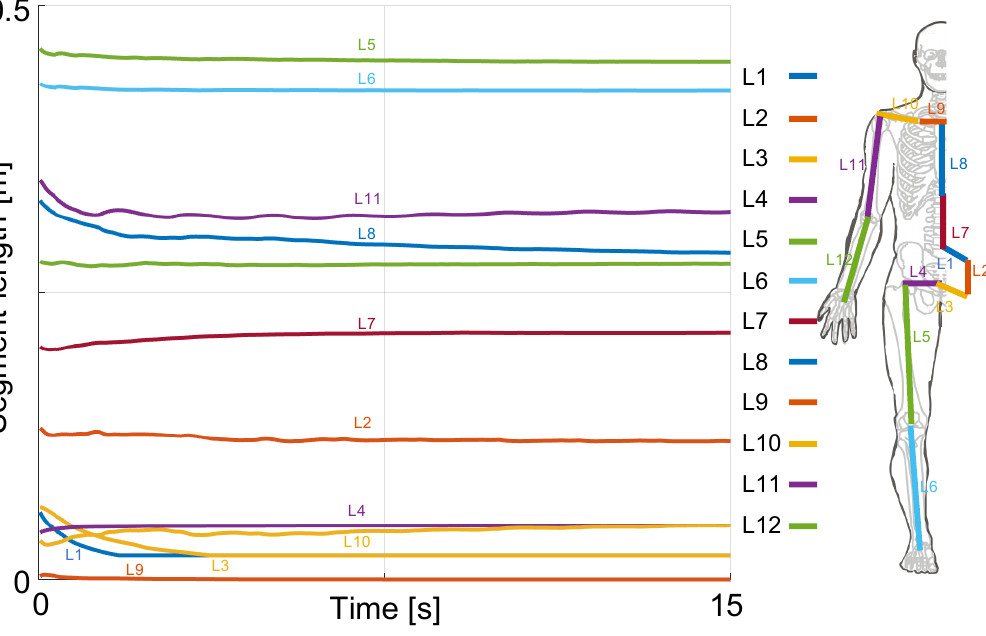
Figure 5. Representative evolution of the estimation of the segment lengths corresponding to the model described in Section 3.1. The segment lengths converge toward a constant fixed realistic